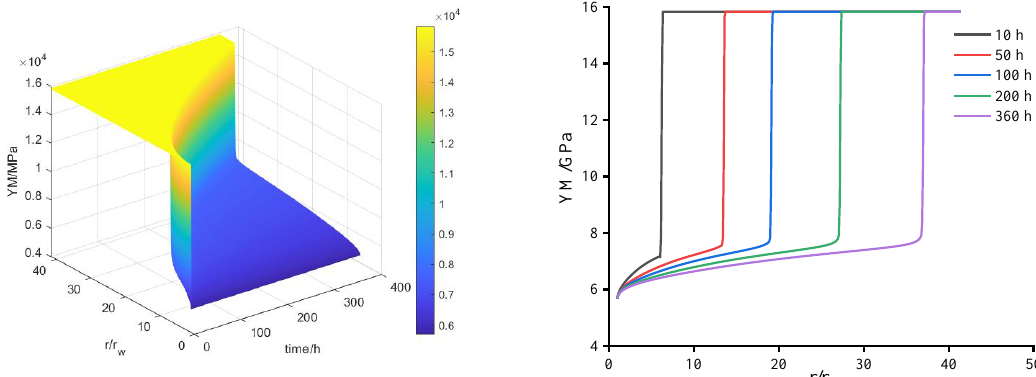
Figure 4. Variation of Young’s modulus with dimensionless distance and time.